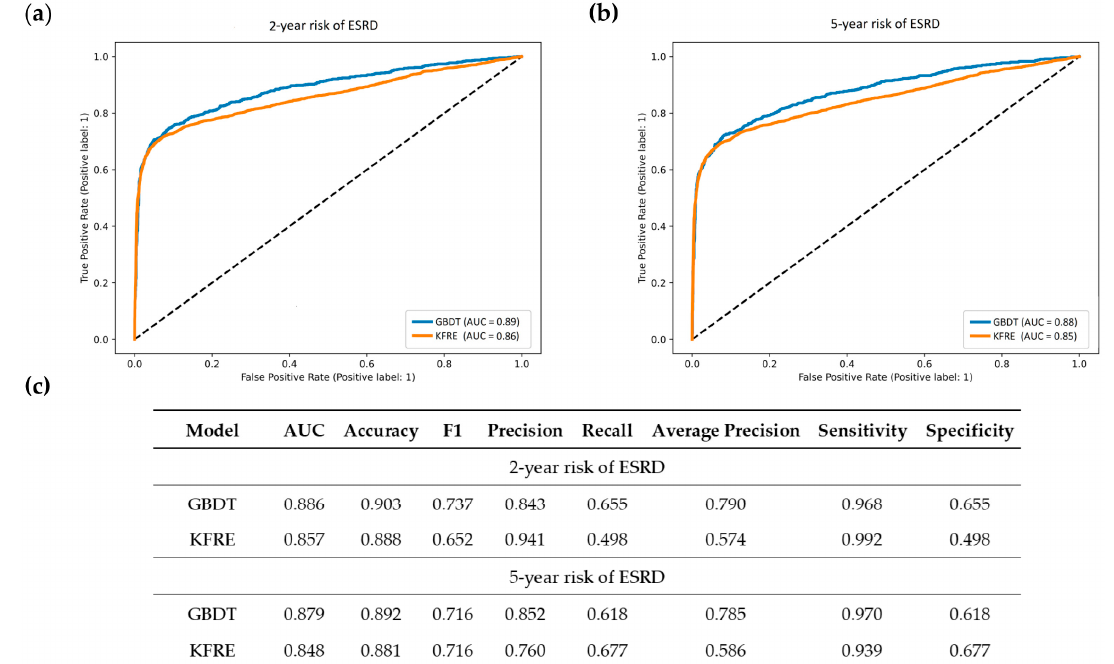
Figure 5. Receiver operating characteristic curves of GBDT prediction model and kidney failure risk equation (KFPE) predicting 2-year risk of ESRD ( a ) and 5-year risk of ESRD ( b ). Comparing the prediction performance of the two models, the GBDT model had a higher AUC, accuracy, and average precision than KFPE in predicting 2-year and 5-year risk of ESRD ( c ). The diagonal dotted line represents an AUC of 0.5. Abbreviations: ROC—receiver operating characteristic; AUC—area under curve; GBDT—gradient boosting decision tree; KFRE—kidney failure risk equation; ESRD—end-stage renal disease.